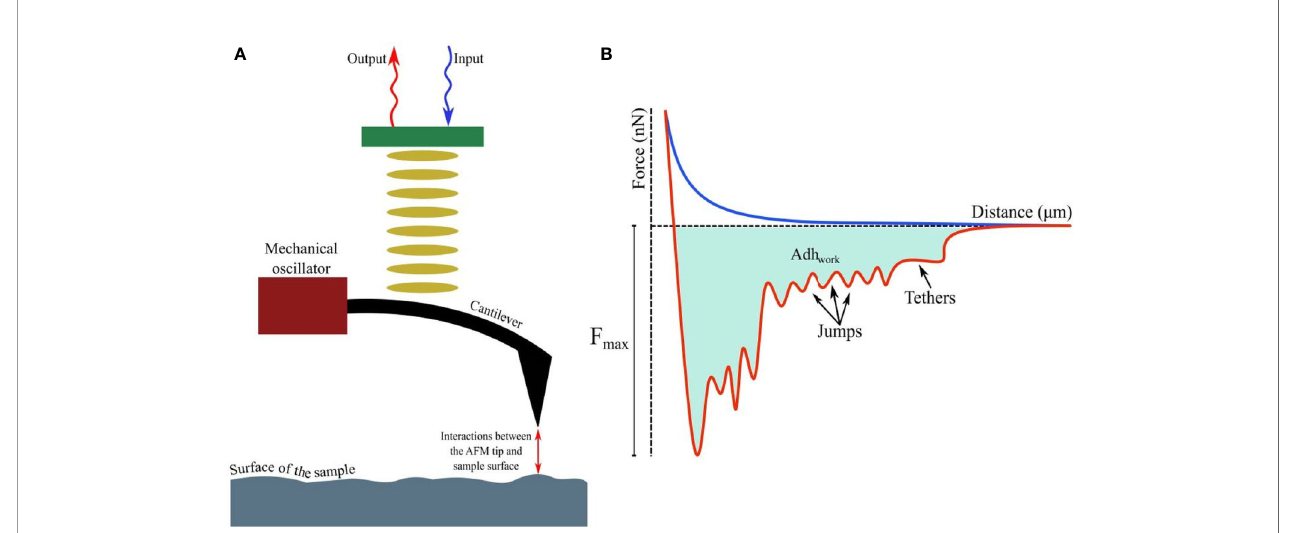
FIGURE 1 | (A) Fundamental principles of AFM showing interactions between the tip and probed surface. (B) The force-distance curve while a (modi fi ed) tip is brought in proximity to another cell, bacterium, or biomaterial. The curves, when the tip is approaching or retreating from the sample, are drawn in blue and red respectively. Receptor-ligand bonds, when strained due to increasing detachment force, are marked as ‘ jumps ’ , while ‘ tethers ’ appear when detachment is complete at F max . The shaded area denotes the total work done (Adh work ) against adhesive